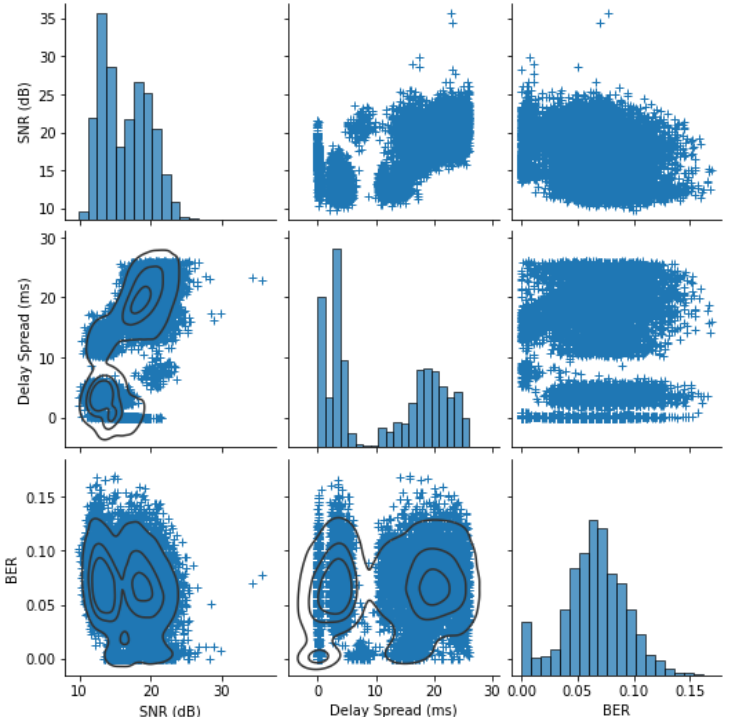
Figure 3. SPACE08: extracted feature distributions with kernel density estimate contours on lower left off-diagonal